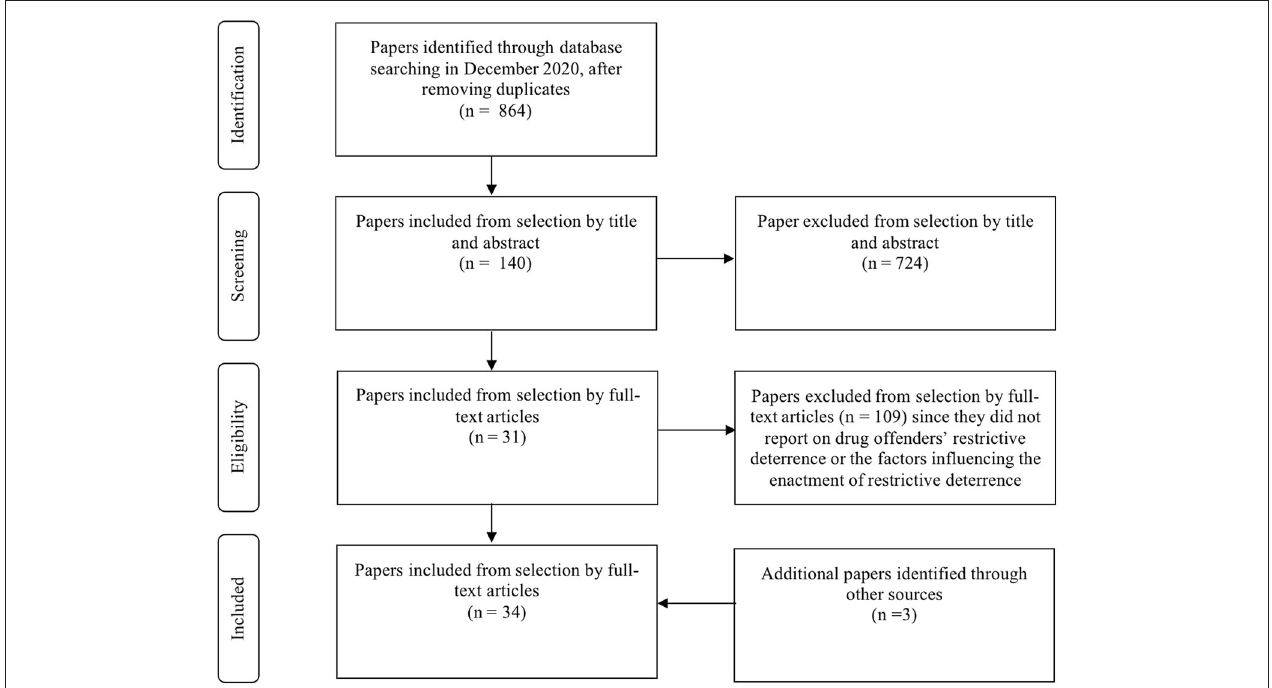
FIGURE 1 | PRISMA flow chart presenting search